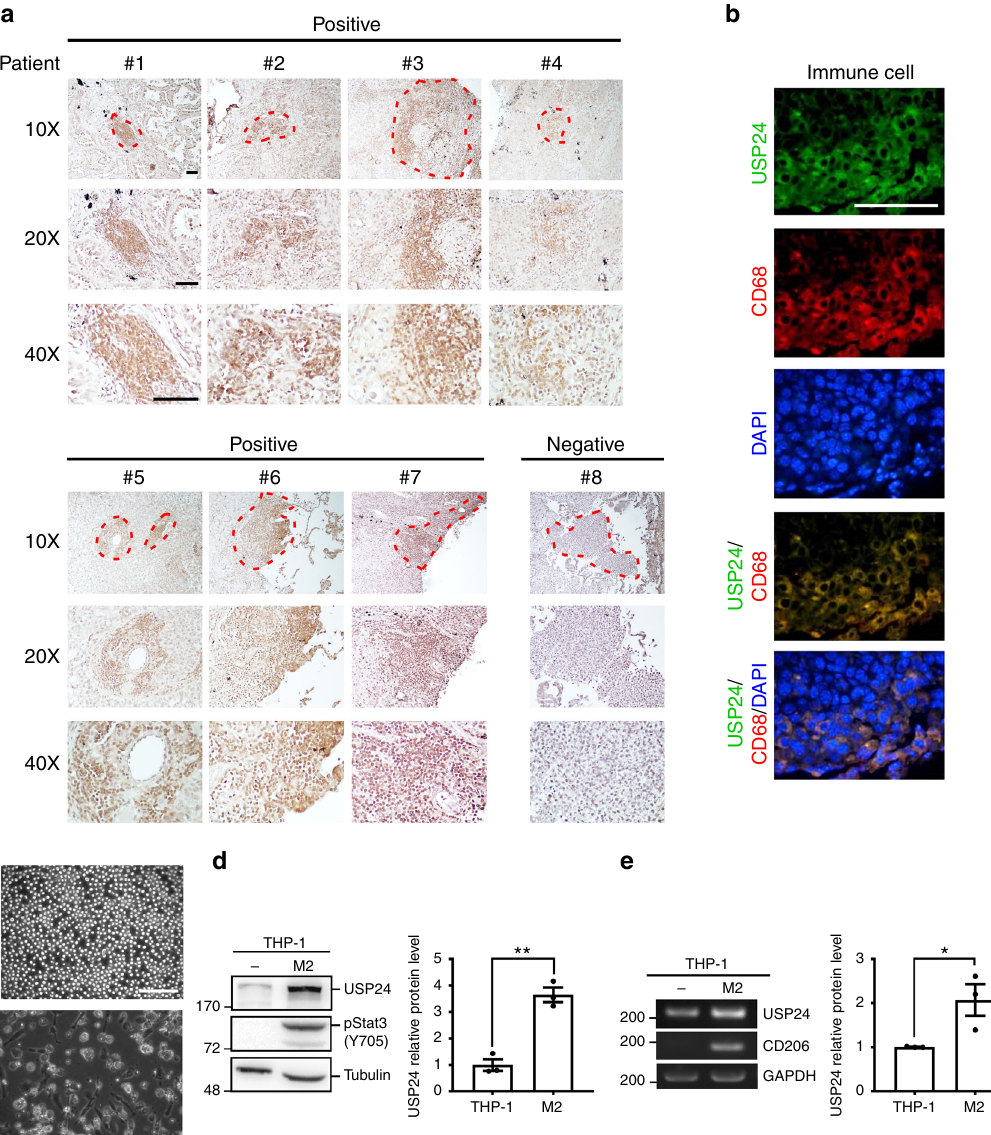
Fig. 1 USP24 level in M2 macrophages. a Representative images of immunohistochemistry staining of USP24 in lung cancer specimens by using anti- USP24 antibody. Leukocytes were circled with red dashed lines. Scale bar represents 200 μ m. b Immuno fl uorescence staining of USP24, CD68, and DAPI in one human lung cancer specimen. Scale bar represents 50 μ m. c Morphological change of M2 macrophages derived from THP-1 monocytes. Scale bar represents 200 μ m. d , e USP24 protein ( n = 3) ( d ) and RNA ( n = 3) ( e ) level in THP-1 and M2 macrophages were analyzed by western blotting and RT-PCR. Results were normalized with tubulin or GAPDH level and expressed as fold of control. Data are shown as mean ± SEM, two-tailed unpaired Student ’ s t -test, * P < 0.05 and ** P <